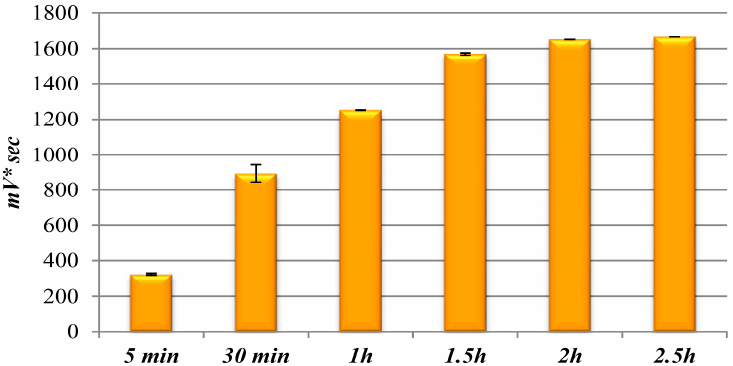
Figure 2. Different derivatization times of 200 nM sphinganine samples: area values obtained by analysis of triplicates. Values are expressed as mean ± SD, n = 6, from two independent experiments.